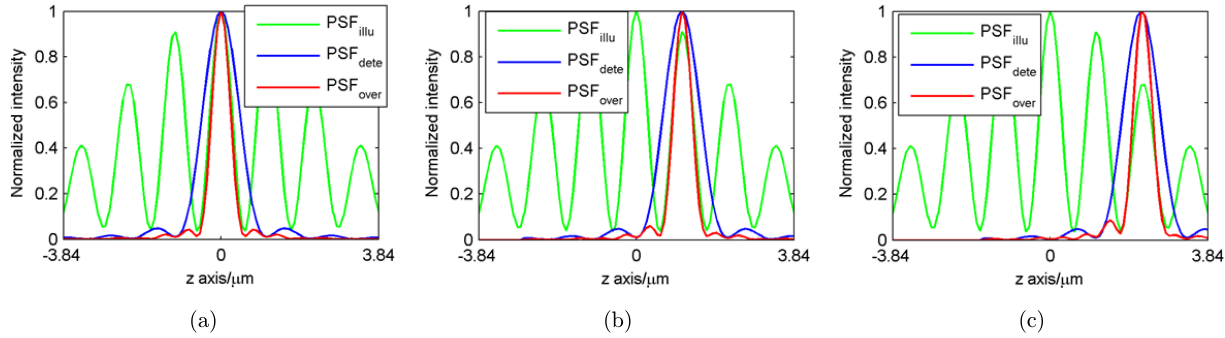
Fig. 7. The condition to suppress background from neighboring light sheets. PSF illu is the point spread function of illumination lens; PSF dete is the point spread function of detection lens; PSF over is the overall point spread